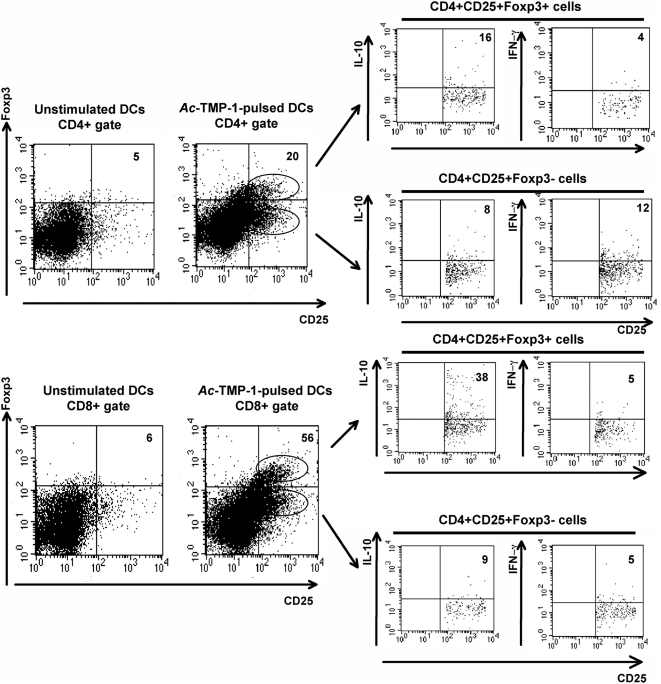

Ac-TMP-1 induces generation of regulatory T cells.Splenic T cells were co-cultured with bone marrow-derived DCs treated with Ac-TMP-1 (50 µg) for 16 h at a T cell: DC ratio of 5∶1. Cells were gated by CD4 or CD8. The percentage of CD25+ expression Foxp3 was first analyzed in the CD4 (upper left) and CD8 (lower left) populations. Then, the expression of IFN-γ or IL-10 in the CD25+Foxp3− or CD25+Foxp3+ populations was determined (right) and indicated at the upper right corner of each histogram. Data shown are representative from 3 independent experiments.